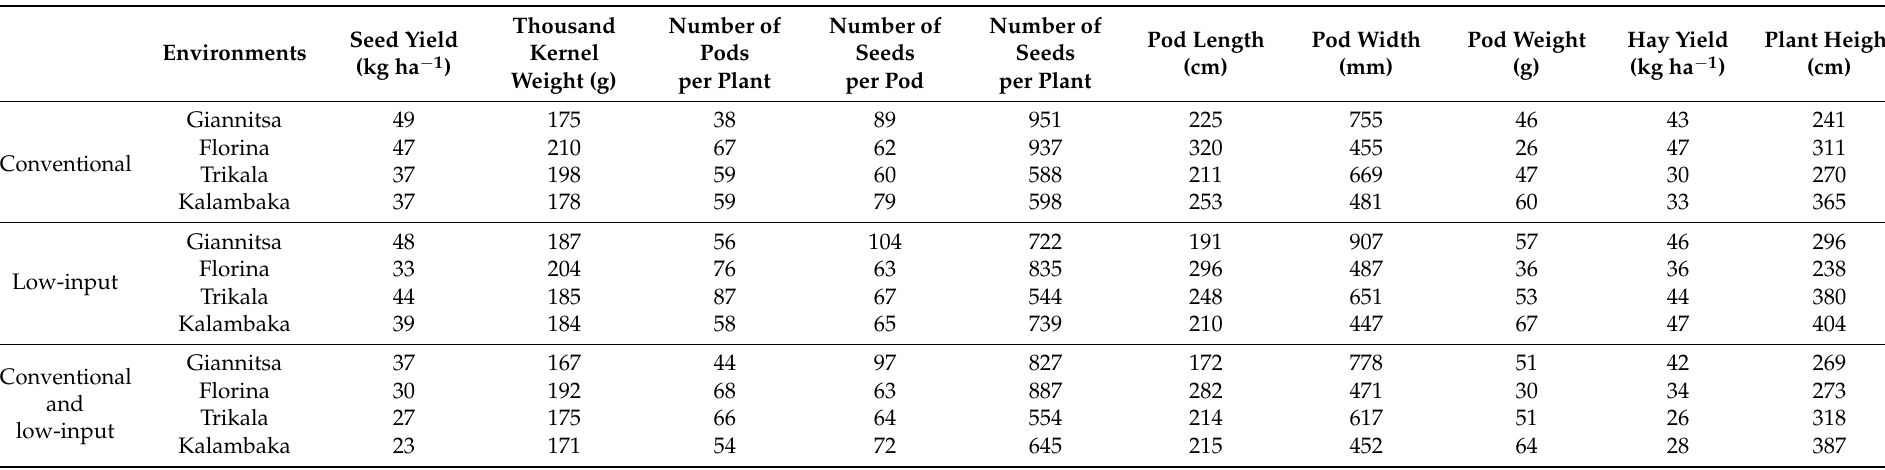
Table 1. Trait stability index across environments for two farming systems: seed yield (kg ha − 1 ), thousand kernel weight (g), number of pods per plant, number of seeds per pod, number of seeds per plant, pod length (cm), pod width (mm), (mean) pod weight (g), hay weight (kg ha − 1 ), plant height (cm).